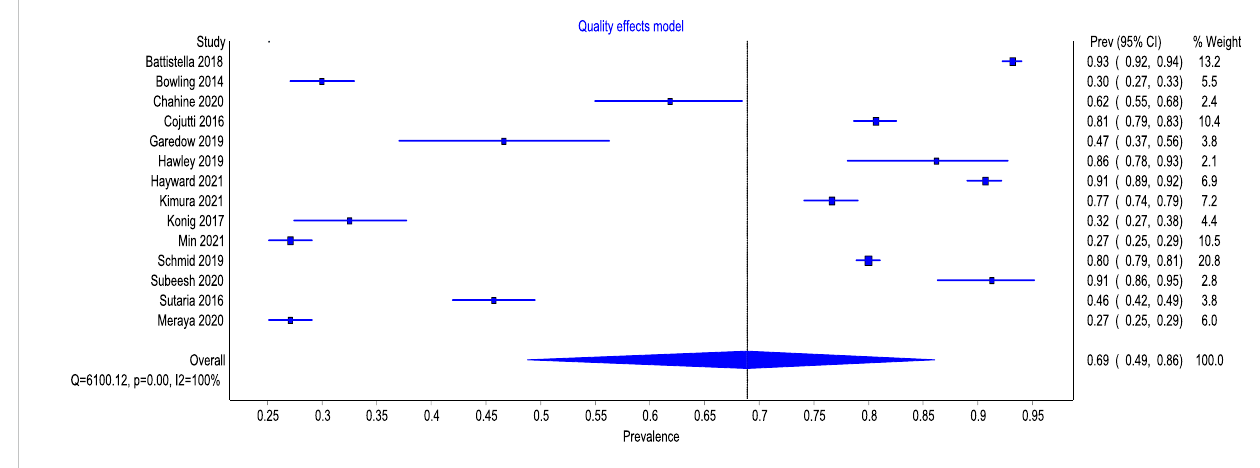
FIGURE 2 Forest plot of the prevalence of polypharmacy among patient with CKD.